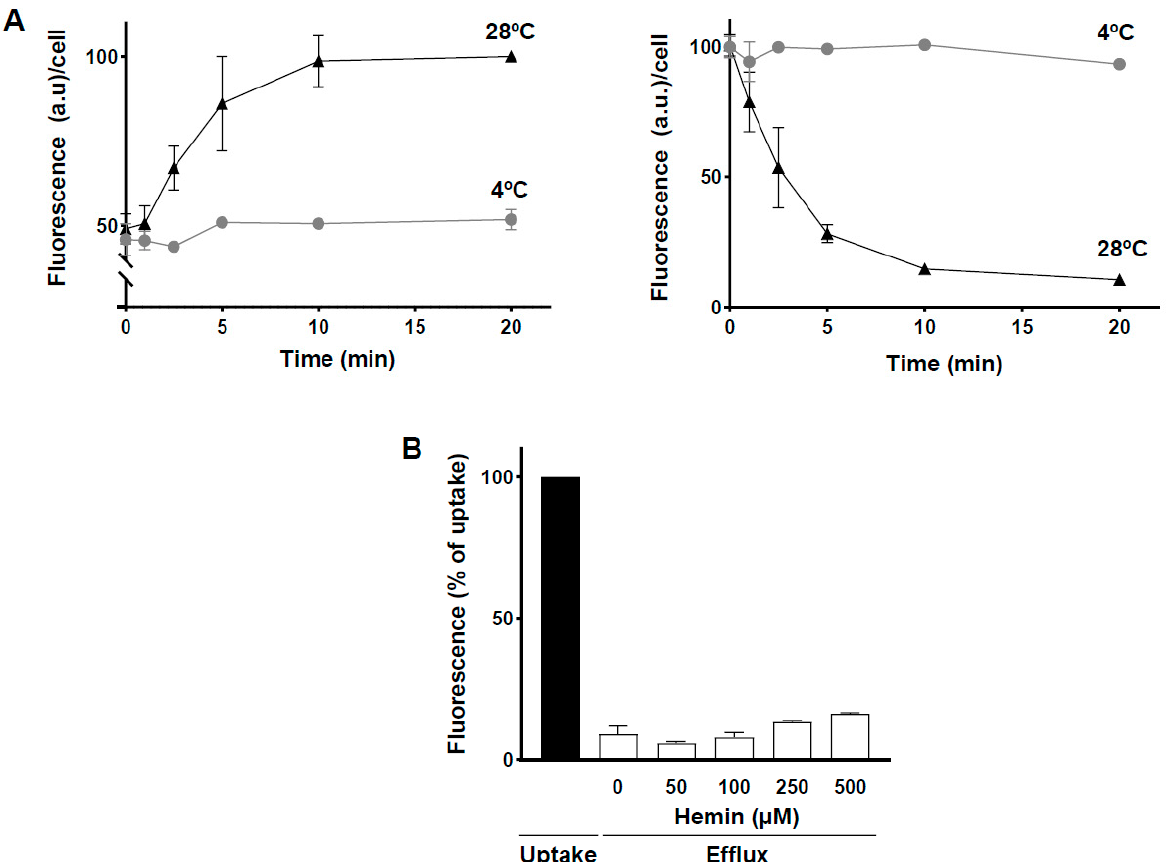
Figure 4. ZnMP efflux in L. major promastigotes. ( A ) ZnMP efflux. Parasites were pre-loaded with 10 µM ZnMP for 20 min at 28 °C, washed, and then incubated in medium without probe (HPMI glucose) at 28 °C (black) or 4 °C (gray) to determine the amount of fluorescent porphyrin retained and released from cells as a function of time. Intracellular ZnMP was measured via flow cytometry (left), while extracellular ZnMP (supernatant) was measured using spectrofluorimetry (right). ( B ) Effect of extracellular hemin on ZnMP efflux. Parasites were pre-loaded with 10 µM ZnMP and then incubated for 10 min in HPMI glucose medium containing increasing amounts (0–500 µM) of hemin at 28 °C (black) or 4 °C (gray). Intracellular ZnMP was quantified via flow cytometry as de- scribed above. The experiment was performed three times in duplicate and data expressed as mean ± SEM.